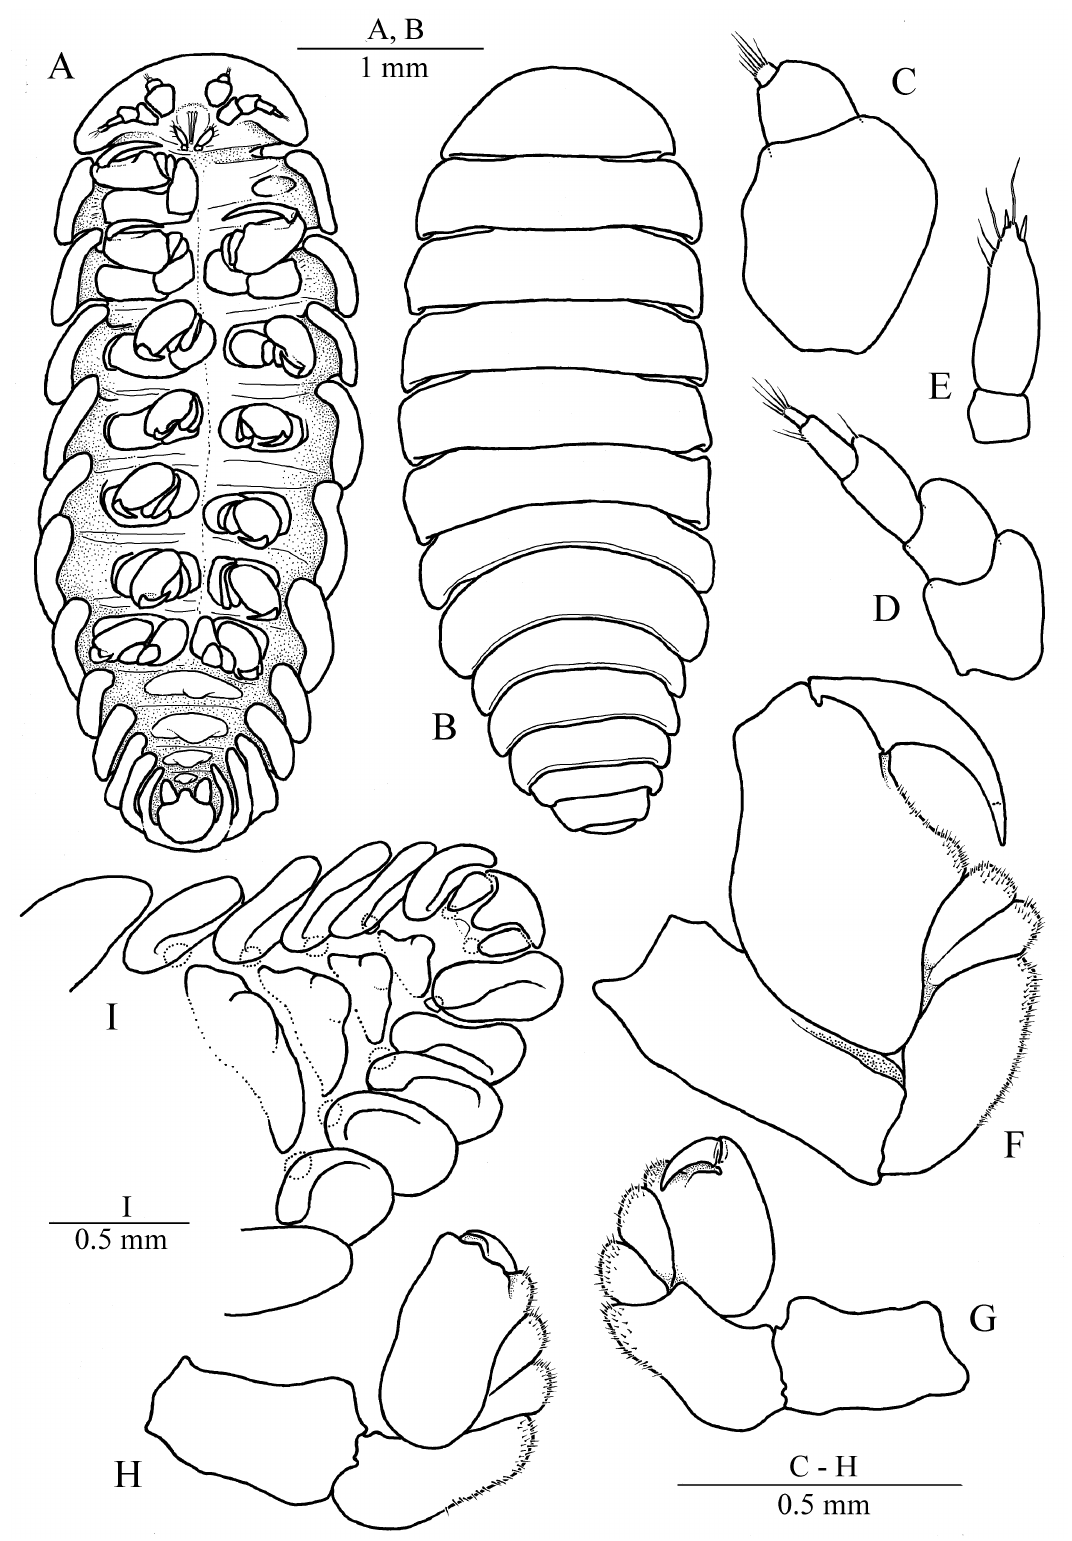
Fig. 3. Pleurocryptella altalis sp. nov., allotype, ♂ ( ZMMU Mc 1421 ). A . Ventral view. B . Dorsal view. C . Right antennule. D . Right antenna. E . Right maxilliped. F . Right pereopod 1, lateral view. G – H . Left pereopod 7, lateral view. I . Pleon, ventral view (pleopods shown in dashed